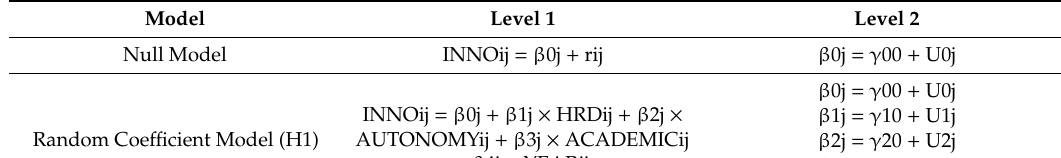
Table 2. Hierarchical Linear Model (HLM) estimation equation for the perception of organizational